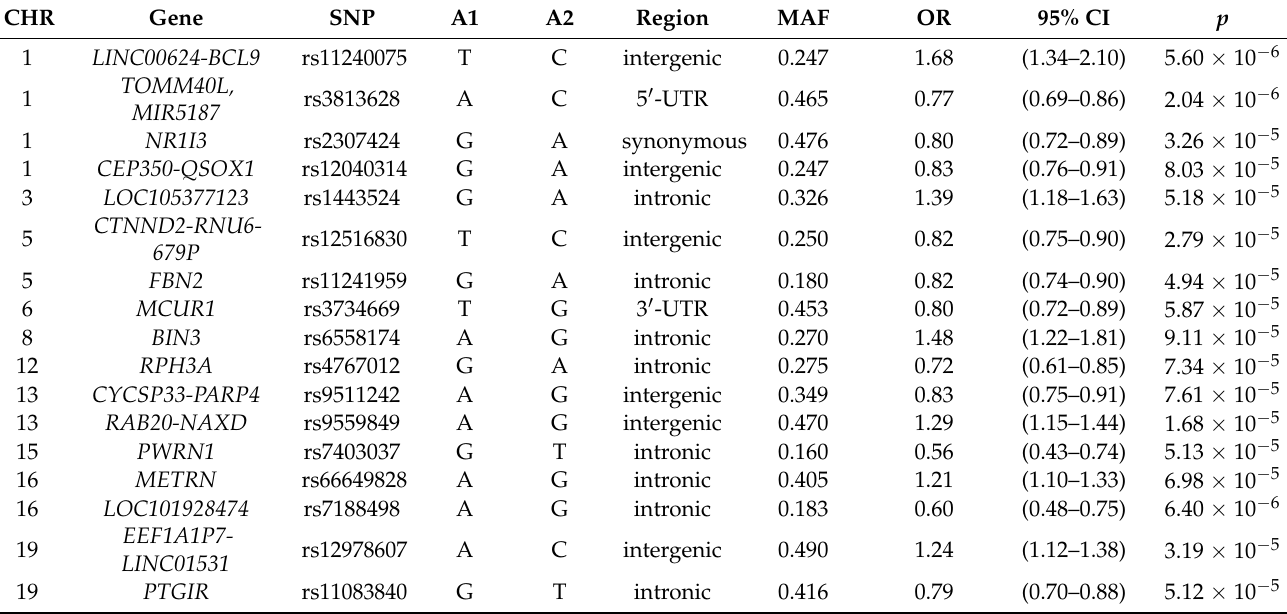
Table 2. Odds ratio analysis with odds ratios after adjustment for covariates between probable MDD and 17 eQTL SNPs.